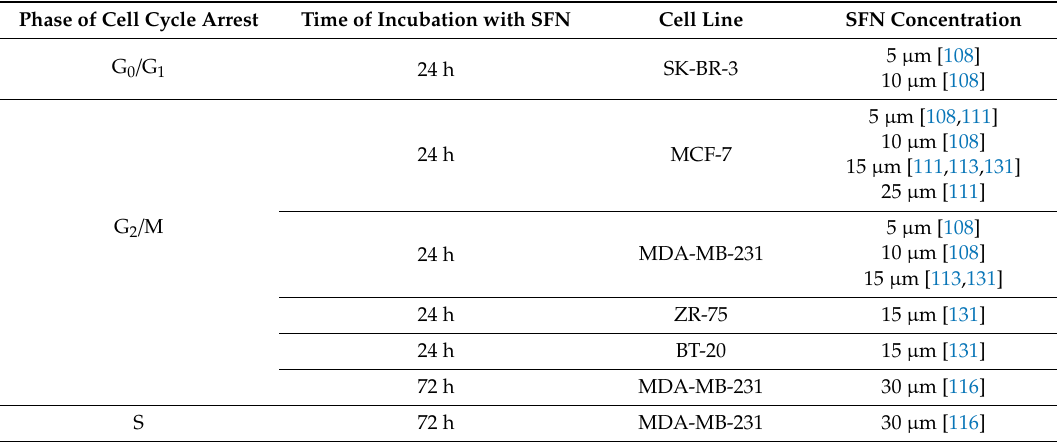
Table 5. Phase of cell cycle arrest induced by SFN in breast cancer cell